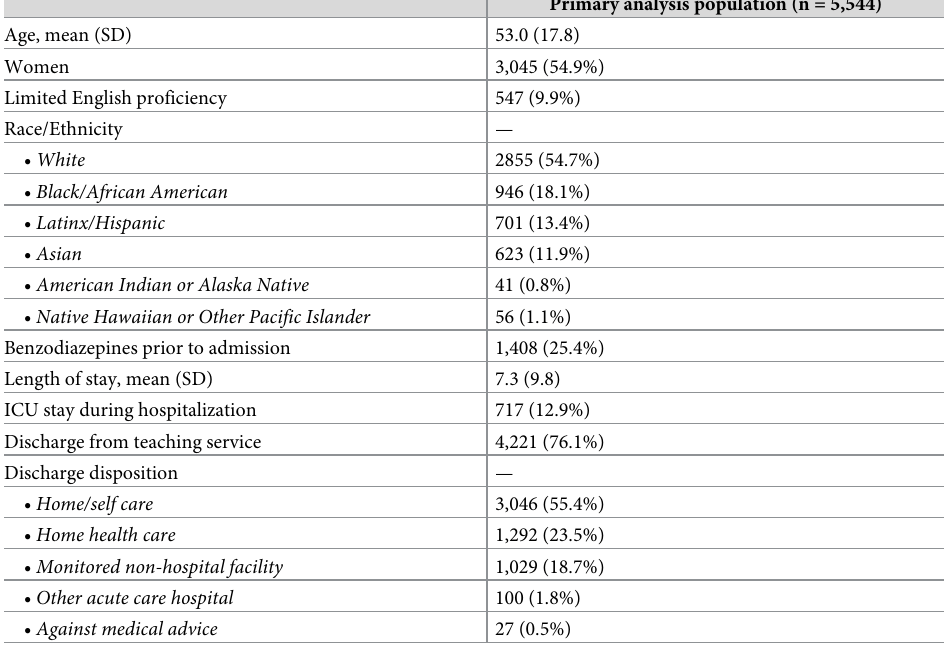
Table 1. Patient